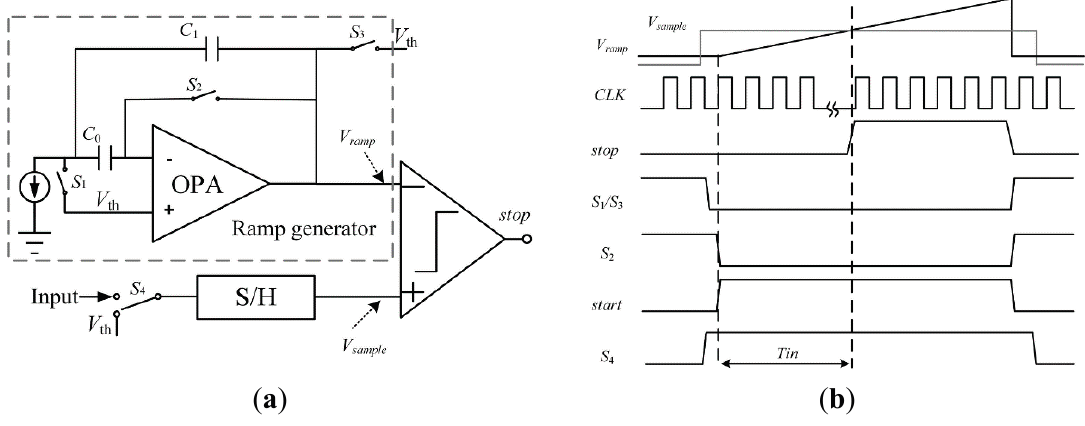
Figure 5. ( a ) Block diagram of ATC; ( b ) Timing diagram of